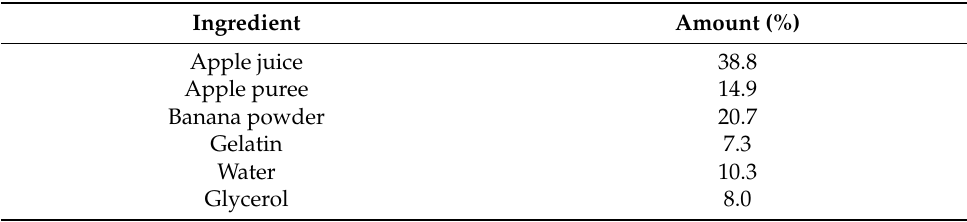
Table 2. Gelatin gel tablets composition.